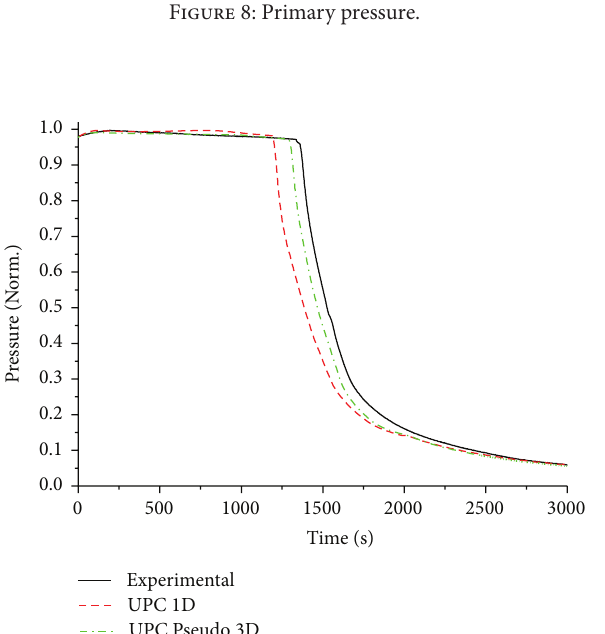
Figure 10: Mass flow